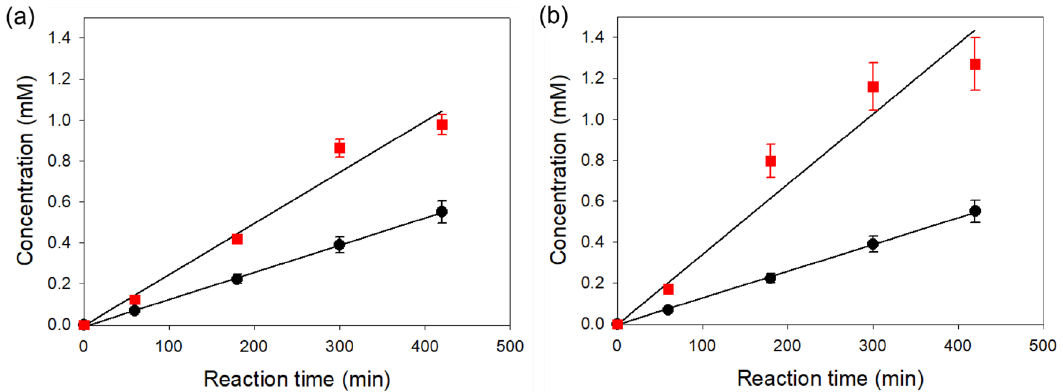
Figure 4. Time course of photodecarboxylations. Decarboxylation of ricinoleic acid ( 1 ) into ( Z )-heptadec-9- en-7-ol ( 2 ) was carried out by the recombinant E. coli cells expressing Cv FAP under green light ( λ = 550 nm). The reactions were performed in the absence (filled black circle) and presence (filled red square) of the PtOEP:DPA@PS nanoparticles, which are involved in light upconversion from green to blue light. Reaction conditions: c (Ricinoleic acid) = 5 mM, c (Cat) = 7.2 g CDW L -1 , c (DPA) = 5 μM ( a ) or 15 μM ( b